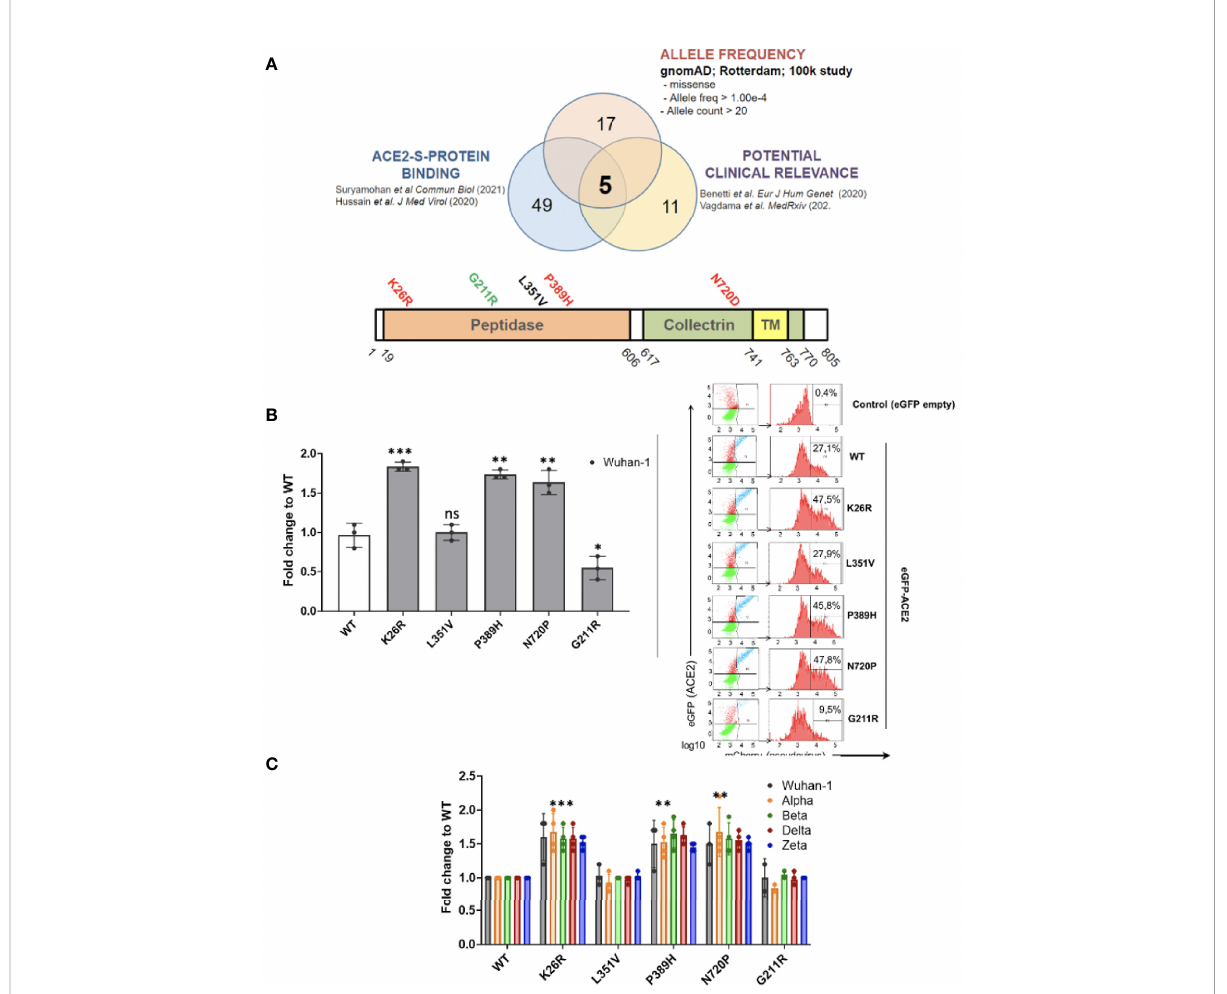
FIGURE 10 ACE2 polymorphisms K26R, P389 and N720D promote SARS-CoV-2 infection in all VOCs. (A) Studying the effect of ACE2 SNPs. Non- synonymous ACE2 single nucleotide polymorphism were selected among those ful fi lling the triple criteria of high allelic frequency (Allele freq > 1.00e-4; Allele count > 20); involved in ACE2-claw S-protein RBD-binding interface and previously associated to clinical outcome. (B, C) Following the strategy described in Fig 9A, A549 cells expressing either GFP-ACE2 either WT or polymorphisms were assayed for cell entry by SARS-CoV-2 pseudovirus expressing either empty vector ( D Spike) or Spike protein corresponding to origin variant (Wuhan-1) or variants-of- concern Alpha, Beta, Delta or Zeta. A representative fl ow cytometry experiment is shown. Bars demonstrate mean and Standard Error of Mean while each data point represents a unique experiment; ***P < 0.001, **P < 0.01, *P < 0.1, ns P >0.1 to WT by two-tailed